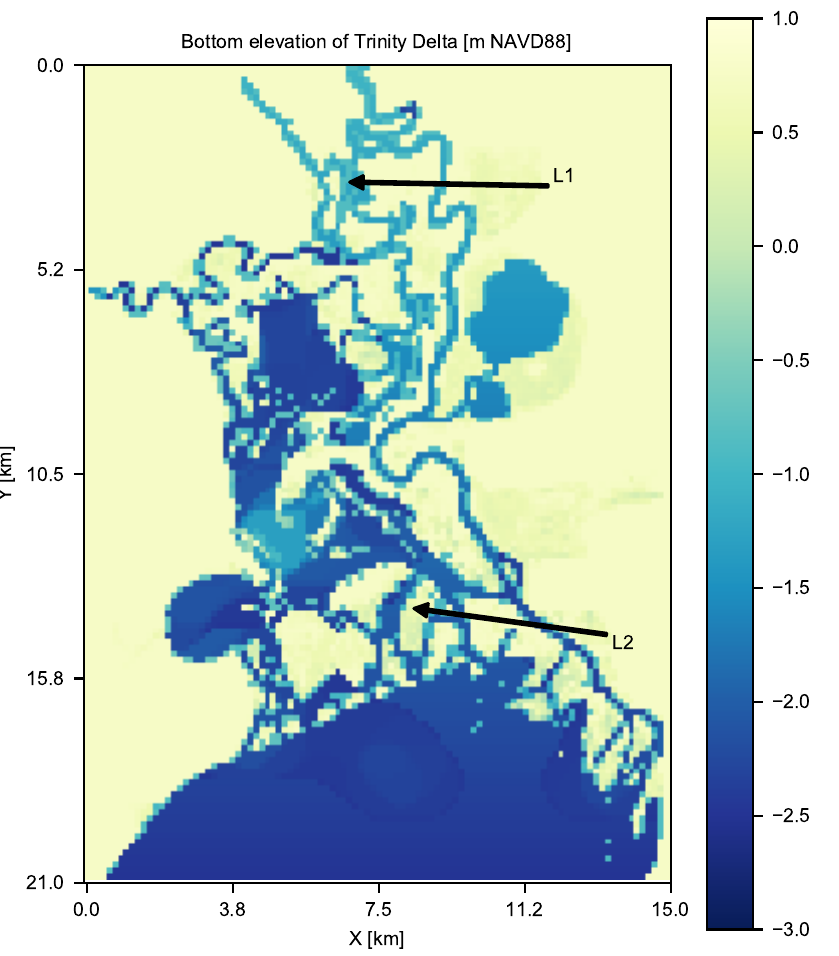
Figure 11. Model bathymetry used for the Trinity Delta test problem (at 150 m grid resolution). L1 and L2 are the location where model outputs are extracted and analyzed. North direction is pointing upward.